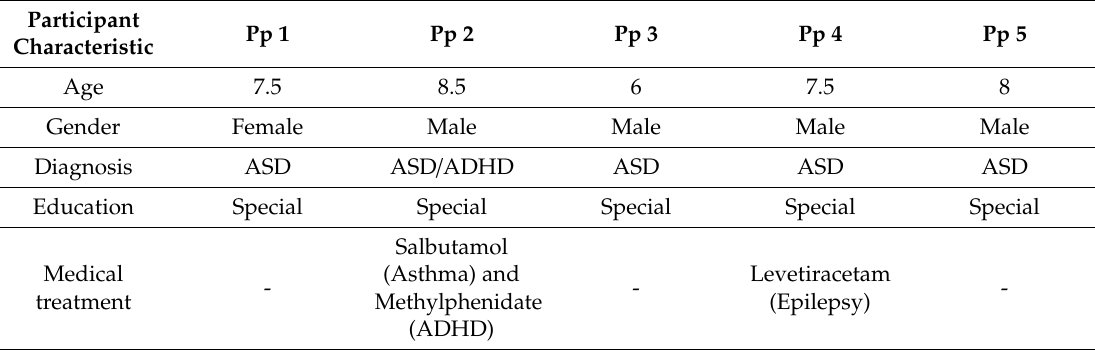
Table 1. Participant